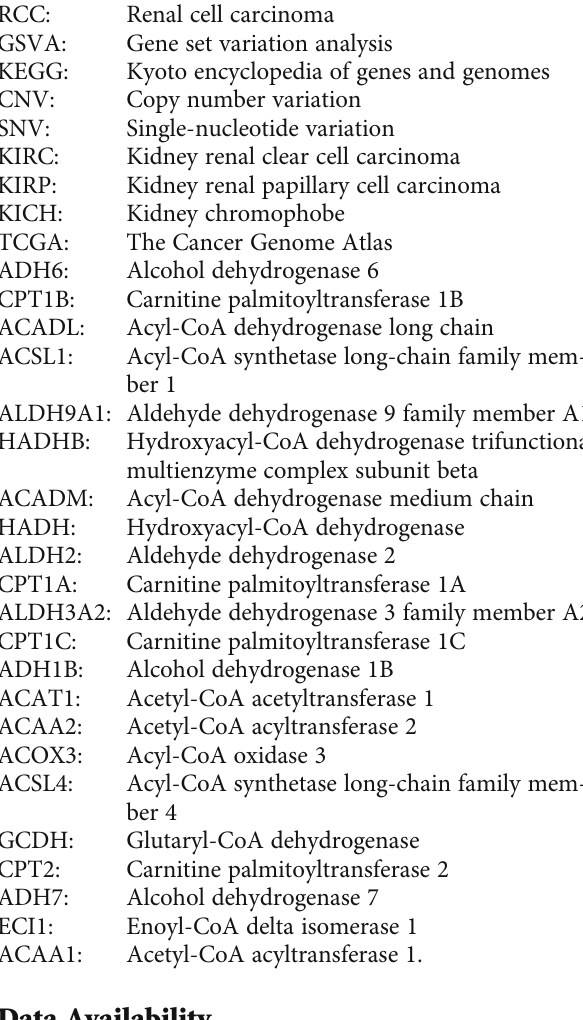
Figure S1: veri fi cation process from GEO database; Figure S2: RT-qPCR technology veri fi es the expression of the ADH6 gene in KIRC tumors and normal tissues.